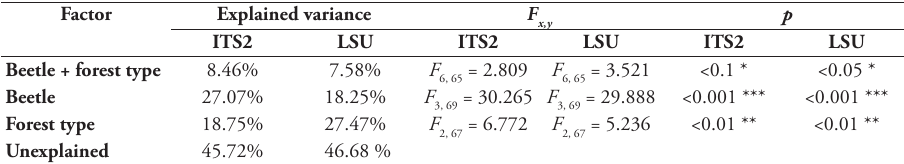
Table 2. Correlation of species richness with beetle species and forest type. The table shows the result of a GLM analysis showing the percentage of explained variance for each predictor with the F parameter and significance